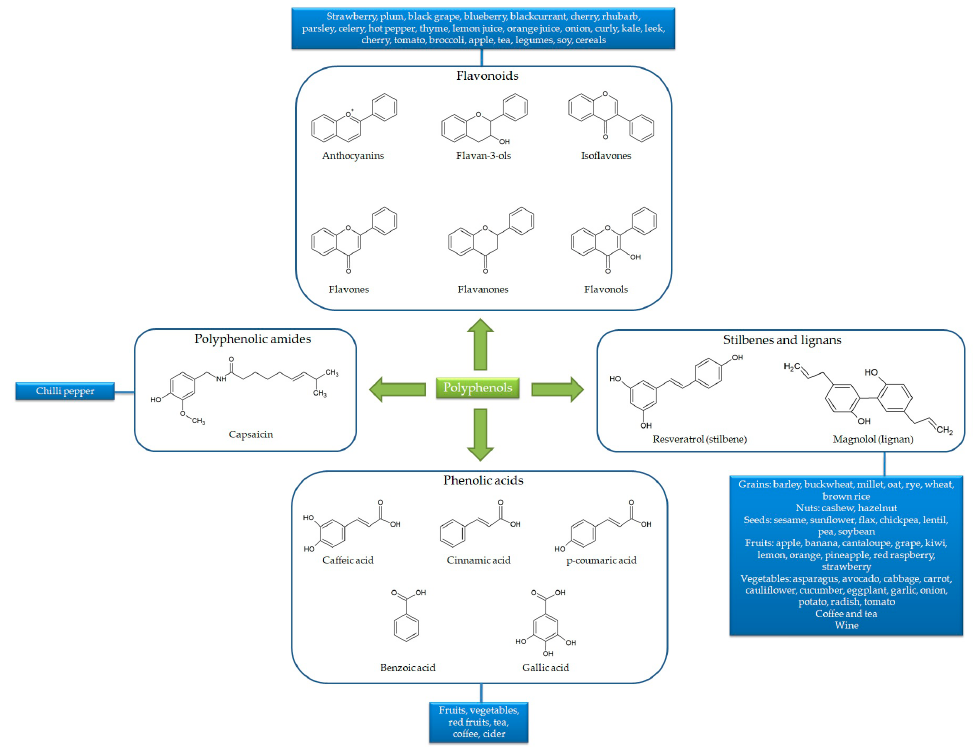
Figure 2. Chemical structures and sources of the main polyphenol